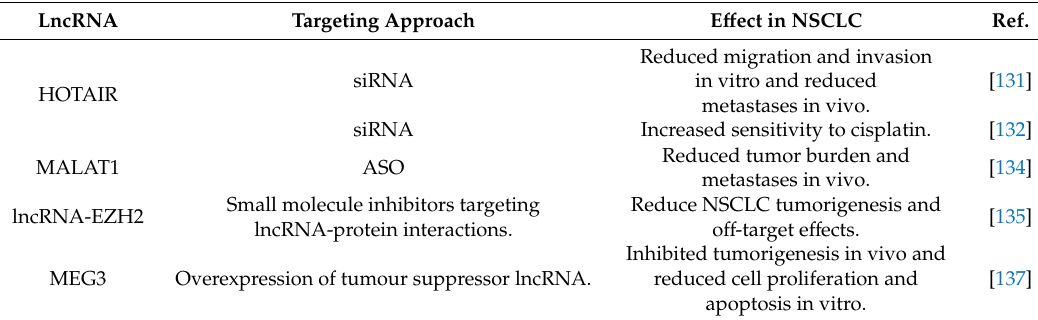
Table 3. Therapeutic targeting approaches in